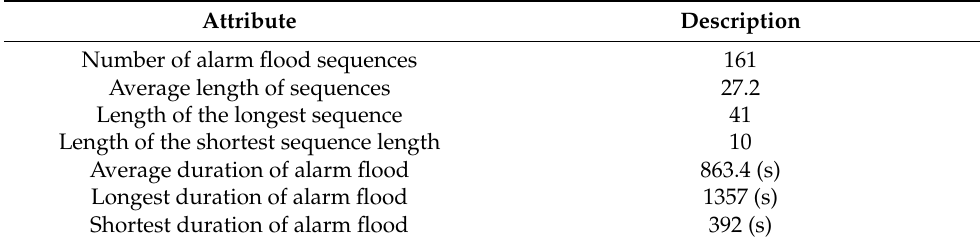
Table 5. Details of the extracted alarm flood sequence database.